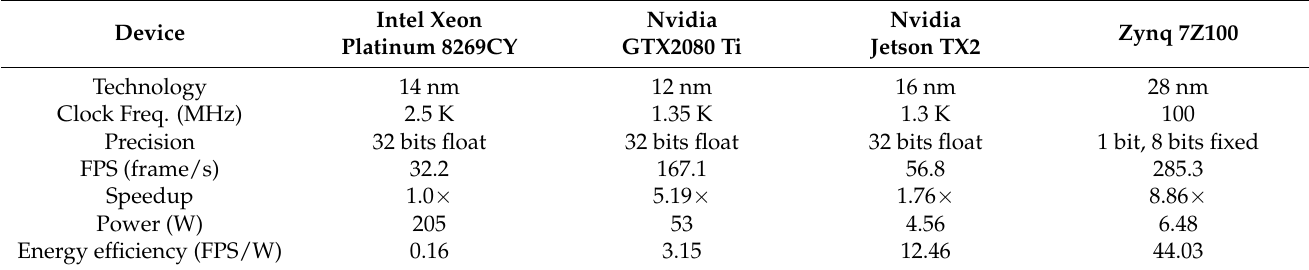
Table 3. Comparison with CPU and GPU